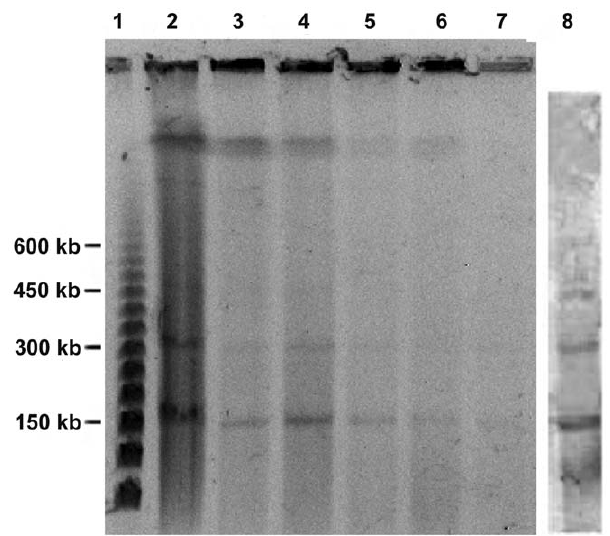
Figure 4. PFGE showing multimeric forms of chloroplasts from the wild (A) and the regenerated (B) B.hypnoides . (A) lane 1: molecular standard marker; lane 2: cpDNAs from crude chloroplasts of B. hypnoides without purification by sucrose density gradient centrifu- gation; lanes 3–7: cpDNAs from different chloroplasts separated by sucrose density gradient centrifugation; lane 8: the cpDNA hybridized with the labeled probe of rbcL gene. (B) lane 1: molecular standard marker; lanes 2–6: cpDNAs from different chloroplasts separated by sucrose density gradient centrifugation (corresponding to the bands 1–5 in Fig. 3); lane 7: the cpDNA hybridized with the labeled probe of rbcL gene.